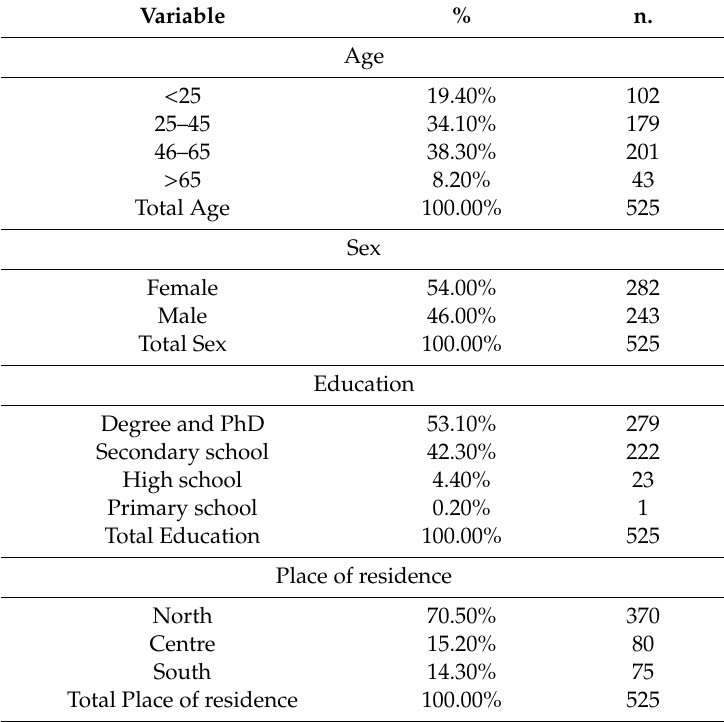
Table 2. Sociodemographic characteristics of the sample.